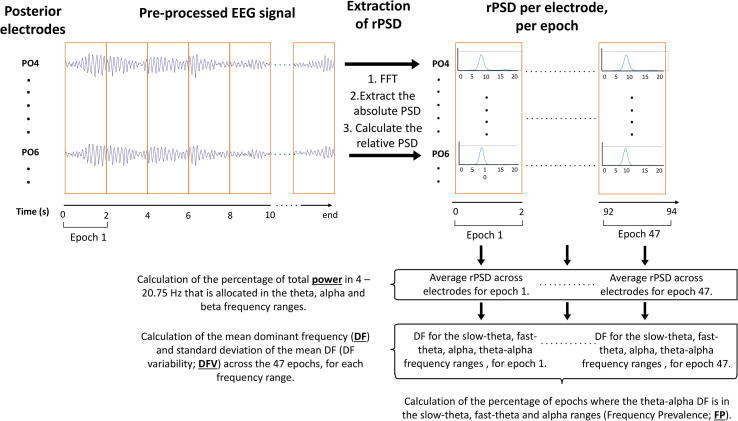
Schematic diagram illustrating the process of extracting each of the four main quantitative EEG variables used in this study, for one participant in the posterior region. The filtered, pre-processed EEG signal on each of the electrodes in posterior derivations (N = 35) is windowed in 2 s long epochs. The signal undergoes fast-Fourier transform (FFT) and using Bartlett’s method the absolute power spectral density (PSD) is calculated for each epoch, for each electrode. The relative PSD (rPSD) is then calculated to normalize the signal. The mean rPSD is obtained across posterior electrodes, for each epoch (up to 47 epochs) of the recording, and the percentage of the total power in the 3–20.75 Hz range allocated to the theta (4–7.75 Hz), alpha (8–13.75 Hz) and beta (14–20.75 Hz) frequency ranges is calculated. The frequency with the highest power within the slow-theta (4–5.5 Hz), fast-theta (5.5–7.75 Hz), alpha and theta-alpha (4–13.75 Hz) frequency ranges was identified within each epoch, and that value corresponded to the dominant frequency (DF). The mean DF and the standard deviation of the mean DF (DF variability; DFV) across epochs were then calculated. Finally, the DF within each epoch was assessed and was characterised to be in the slow-theta, fast-theta or alpha range. The epochs that were characterised by a DF within each of these ranges are shown as a percentage of the total number of epochs. These percentages were the slow-theta, fast-theta and alpha frequency prevalence (FP). The same procedure was followed for the other three cortical regions.